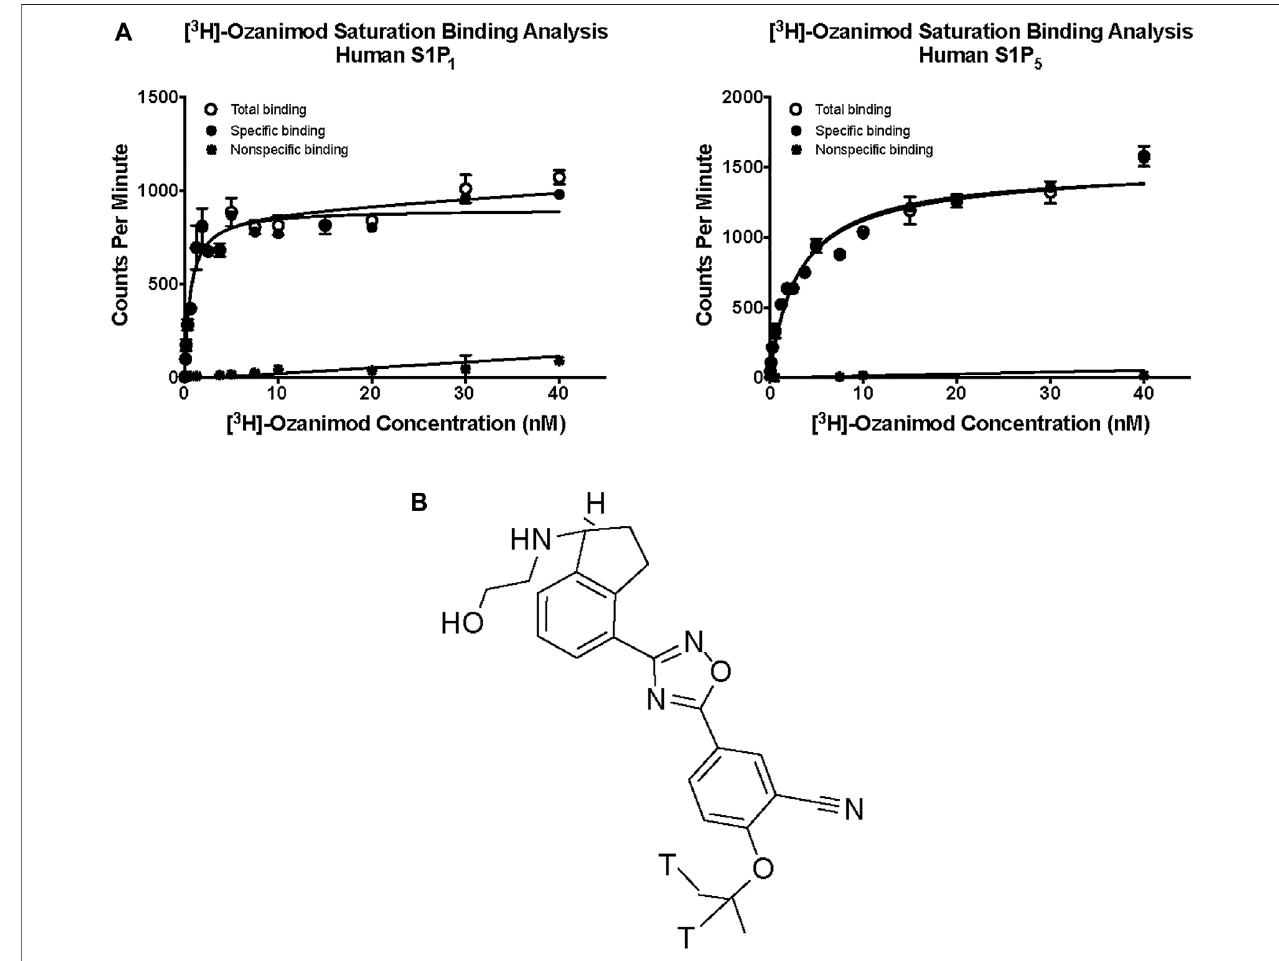
FIGURE 1 | (A) Saturation binding analysis for [ 3 H]-ozanimod to human S1P 1 and human S1P 5 . (B) Structure of [3H] ozanimod. S1P1, sphingosine 1-phosphate receptor subtype 1; S1P5, sphingosine 1-phosphate receptor subtype